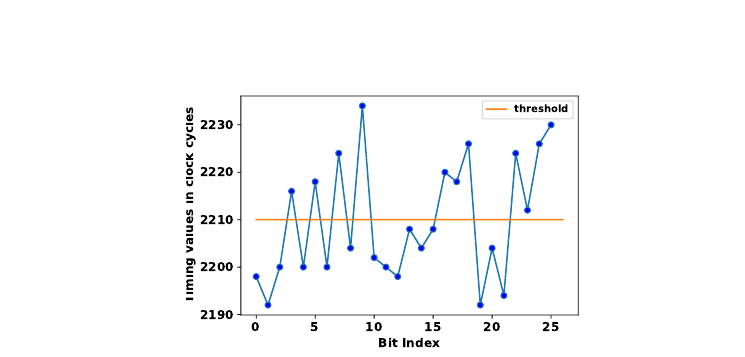
Figure 4: Timing values observed through RASSLE reveals the information transmitted. The values above the threshold indicate a ‘1’ and values below the threshold indicate ‘0’. Thus it reads "00010101010000001110001111". Apart from the first two bits, the rest of the character stream can be constructed without any error. Table 1: Comparison of POC covert channel on various systems Sl.